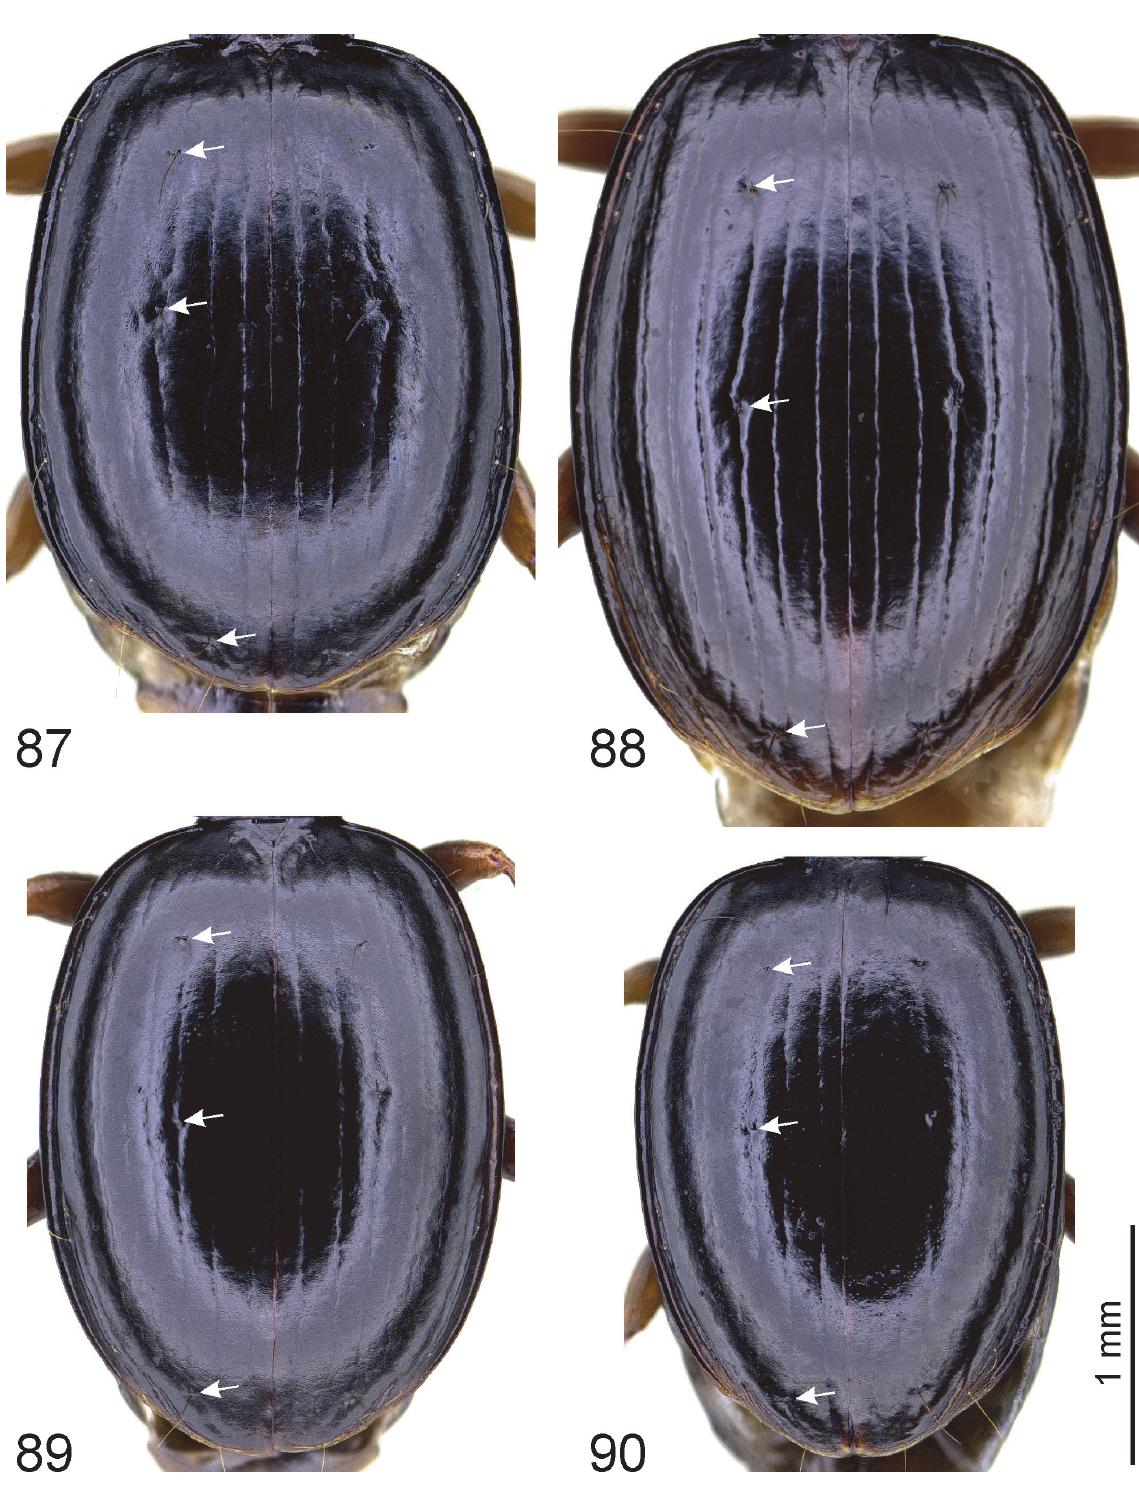
Figs 87–90. Trechus spp., elytra. 87 . T. wiersbowskyi sp. nov., paratype, ♂. 88 . T. grandipennis sp. nov., holotype. 89 . T. sanettii sp. nov., paratype, ♂. 90 . T. abalkhasimi sp. nov., paratype, ♂. The arrows point to the insertions of the discal setae and the preapical